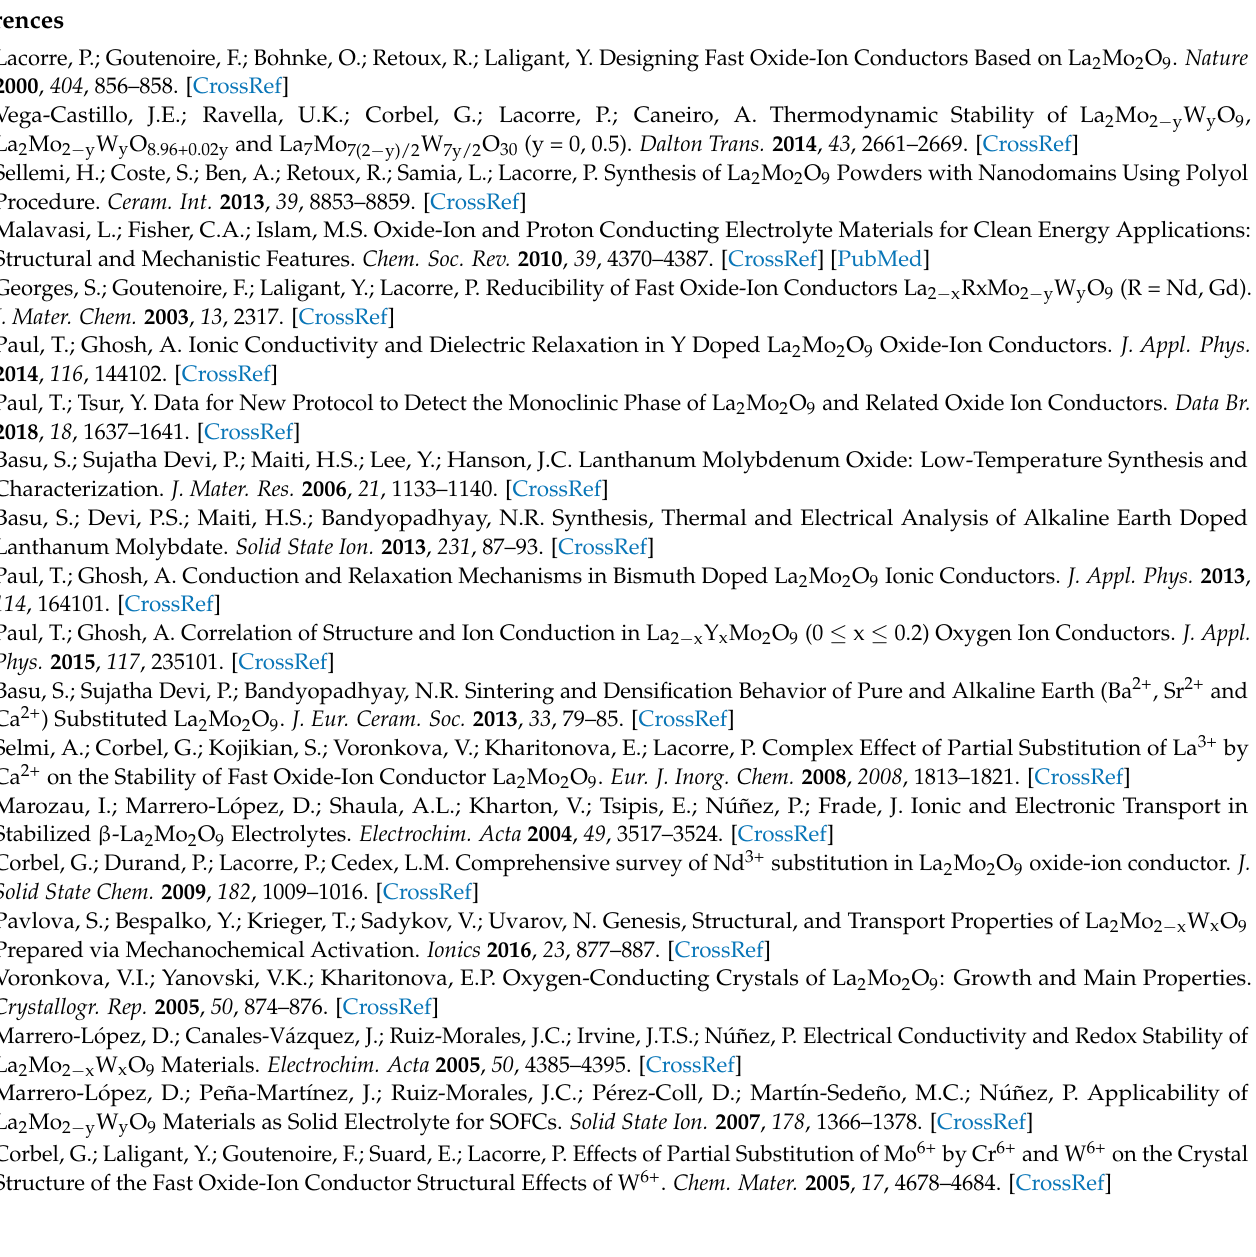
for 1.5 W. Figure S9. Reciprocal temperature dependence of grain and grain boundary conductivities. “g”: grain and “gb”: grain boundary. The linear least-squares fits are not shown for better